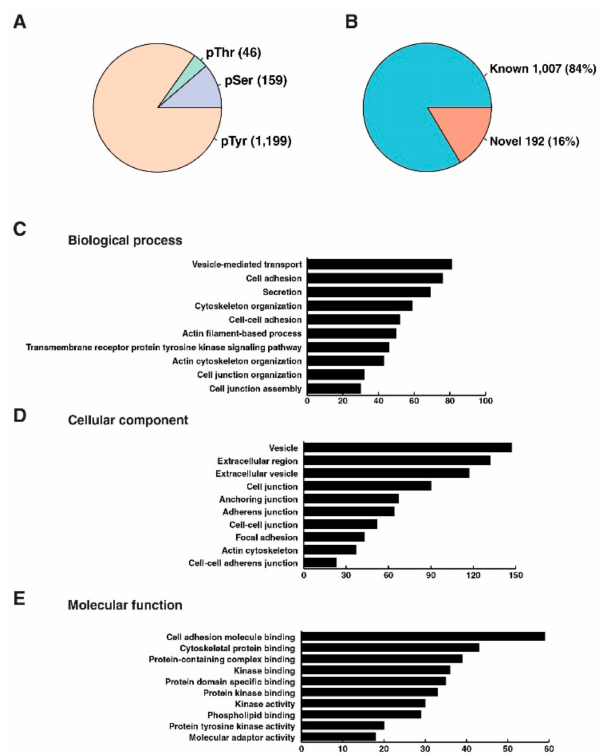
Figure 2. Summary of tyrosine phosphoproteome and gene ontology analysis: ( A ) Phosphosites identified from humans included 1199 phosphotyrosine, 159 phosphoserines, and 46 phosphothre- onine with unambiguous site localization; ( B ) 192 of the identified phosphosites constituted 16% of identified phosphosites were found to be novel based on PhosphoSitePlus database; ( C – E ) Inge- nuity pathway analysis (IPA) was used for gene ontology analysis including biological process ( C ), cellular component ( D ) and molecular function ( E ). The x-axes indicate the number of proteins in each